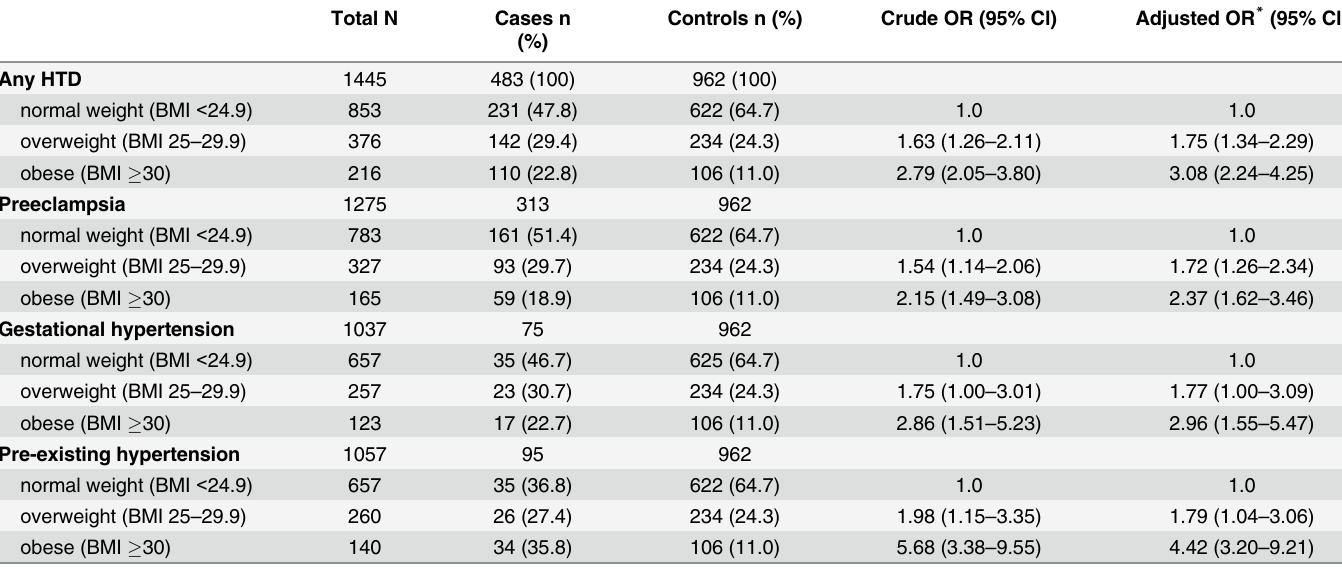
Table 2. Association of Body Mass Index with Hypertensive Disorders during